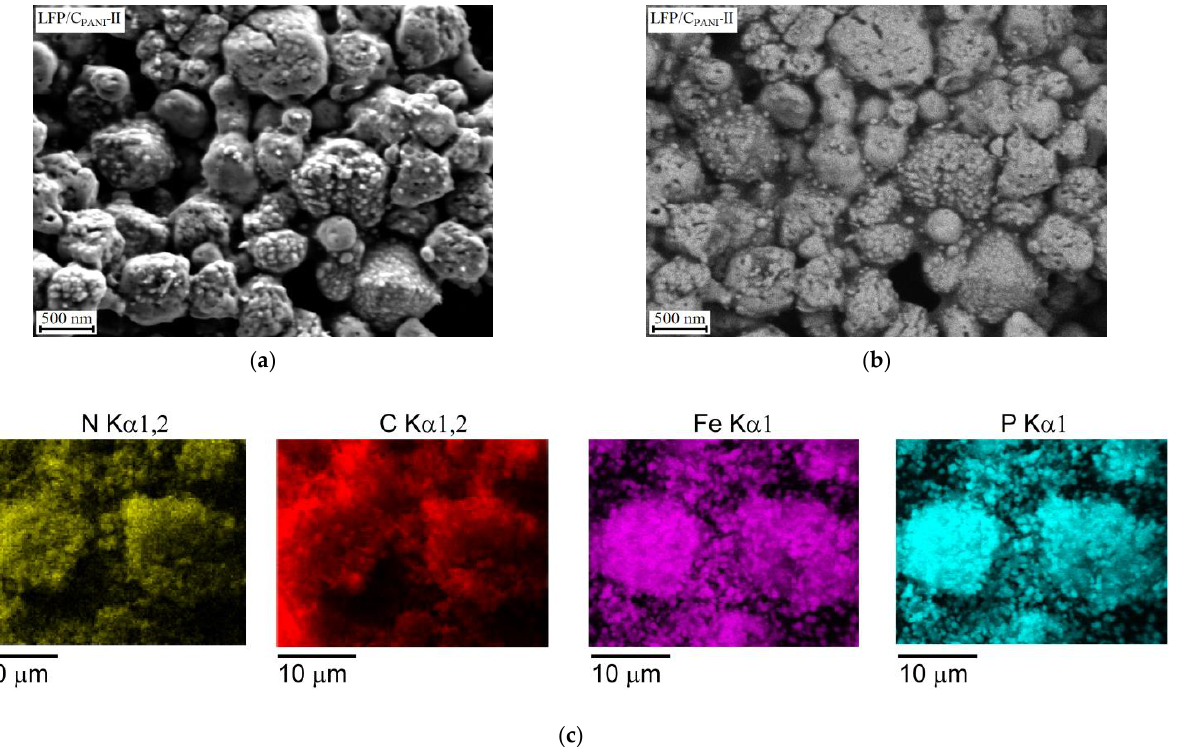
Figure 3. SEM images of LFP/C PANI -II in the secondary ( a ) and backscattered ( b ) electrons; element mapping of LFP/C PANI -II: N, C, Fe, and P ( c ).